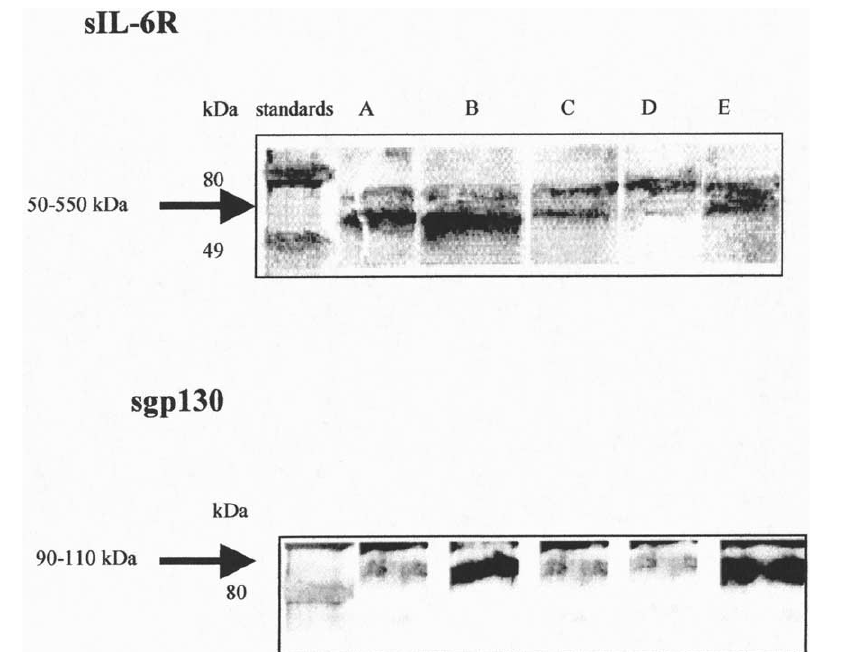
FIG. 1. Western blot analysis of sIL-6R and sgp130 proteins expression in human PMN and PBMC cells. We showed detection of sIL-6R and sgp130 proteins from human unstimulated (line A) and LPS-stimulated (line B), rhIL-15-stimulated (line C), rhIL- 18-stimulated (line D), and rhIL-15 (cid:2) / rhIL-18-stimulated (line E) PMNs. Whole cell lysates were obtained from fresh PMN of healthy donors. One hundred micrograms of total proteins from PMN were loaded onto a 10% sodium dodecyl sulfate (SDS)- polyacrylamide gel electrophoresis and transferred to a nitrocellulose filter. The filter was incubated with 1:1000 dilution of respective antibody. Sizes of protein standards are given in kilodaltons. One representative western blot of a few independent experiments is